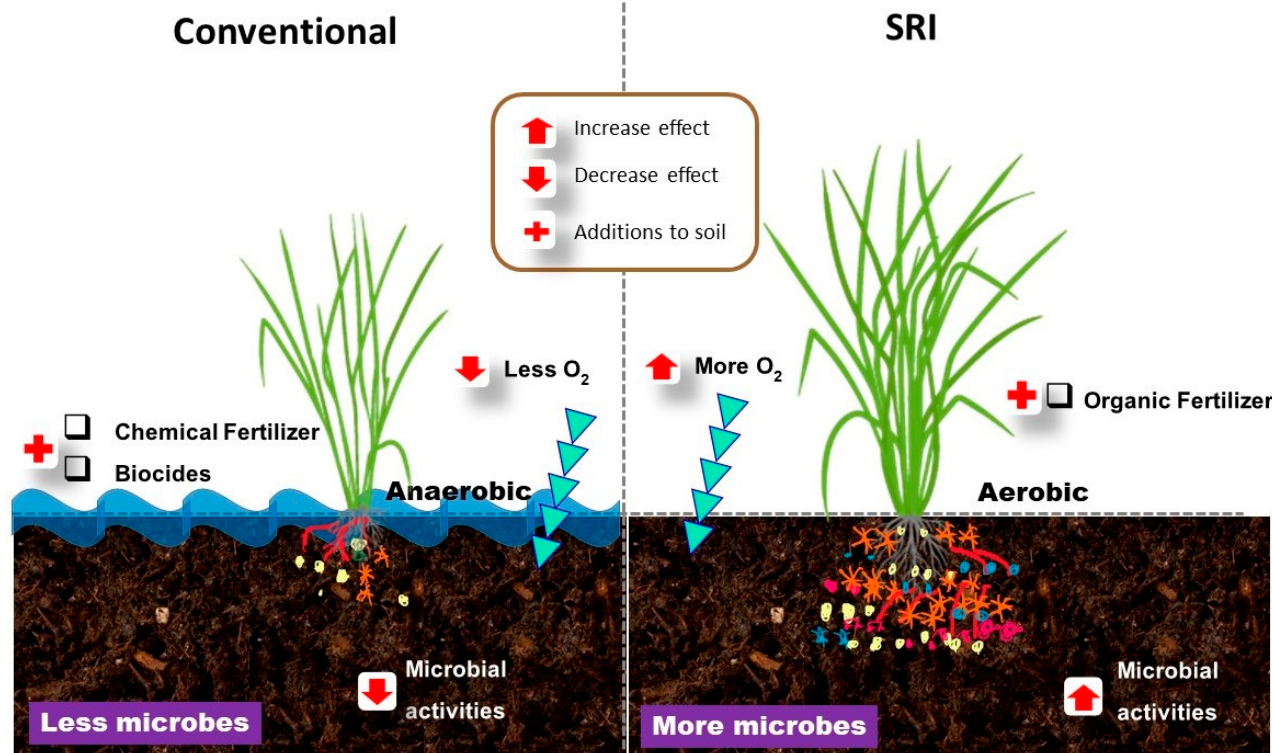
Figure 1. SRI methods produce more robust plant growth and health ( right ) than conventional grown plant ( left ). This is due to the SRI agroecosystems providing a more supportive environment for microbes to grow and to benefit rice plants, while conventional methods limit microbes’ growth and inhibit their effects. If this model is transposed to the larger scale of an SRI rice field, it is understandable why SRI plants achieve higher growth performance and yield as well as more resistance to biotic and abiotic stresses. In SRI rice fields, many and diverse microbes exist and interact with rice plants. Subsequently, this synergetic relationships between SRI methods and microbes affected the rice plant growth, physiological processes, yield, and patterns of gene expression.